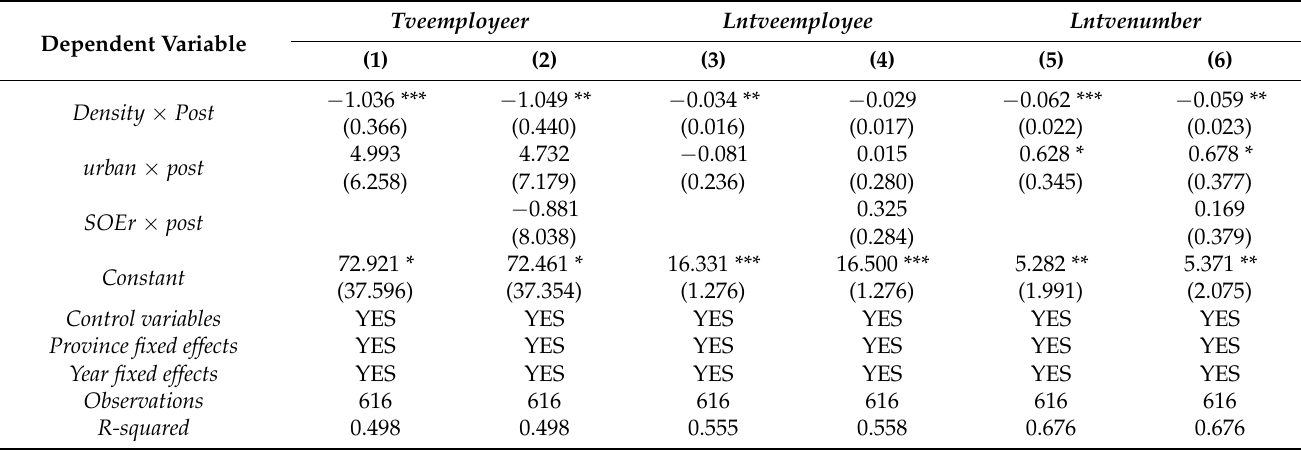
Table 9. Robustness tests: eliminating the interference of other